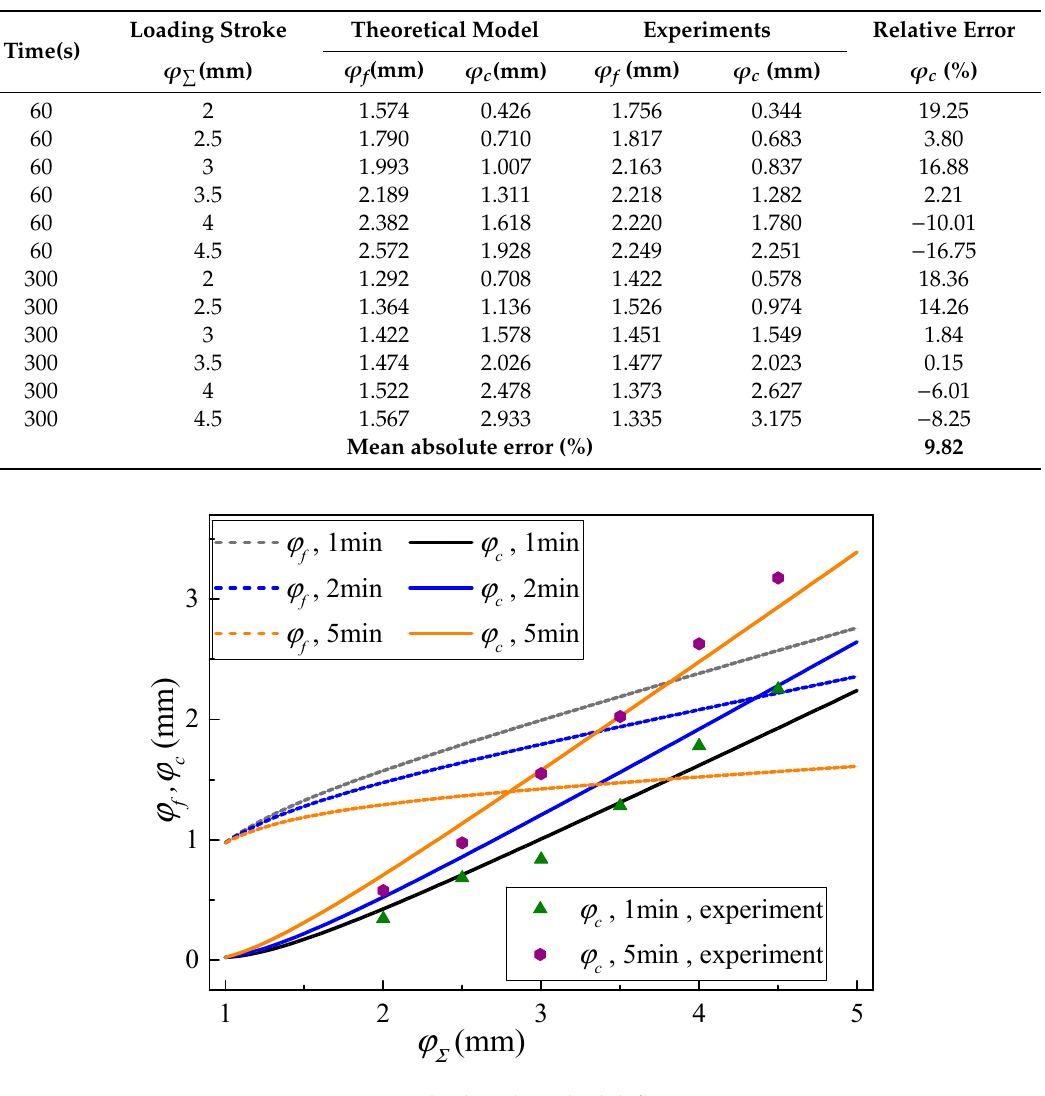
Figure 10. Springback and residual deflection curve.